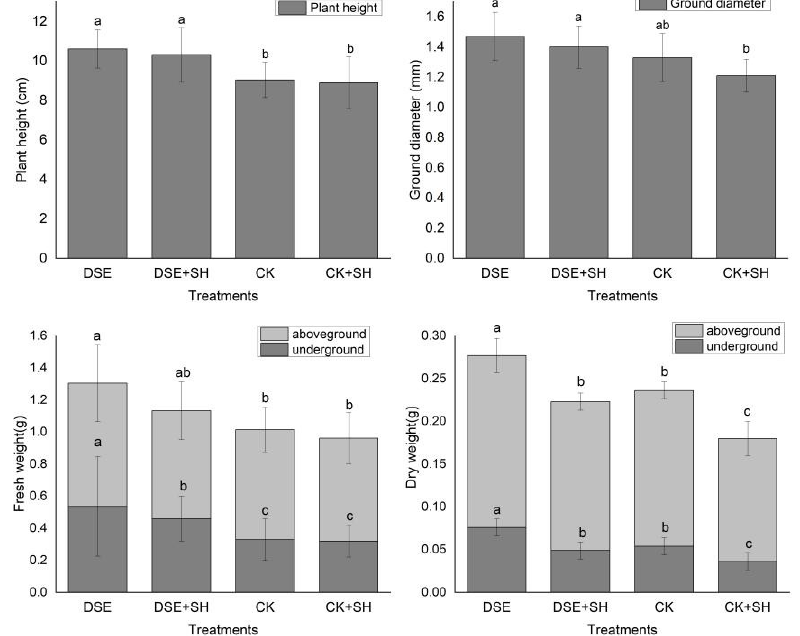
Figure 1. Effects of P. bamuru A024 inoculation on plant growth. CK: inoculation with cottonseed shell blank culture medium. DSE: single inoculation with P. bamuru A024. CK + SH: Single inoculation with R. solani SH01. DSE + SH: sequential inoculation with P. bamuru A024 and R. solani SH01.